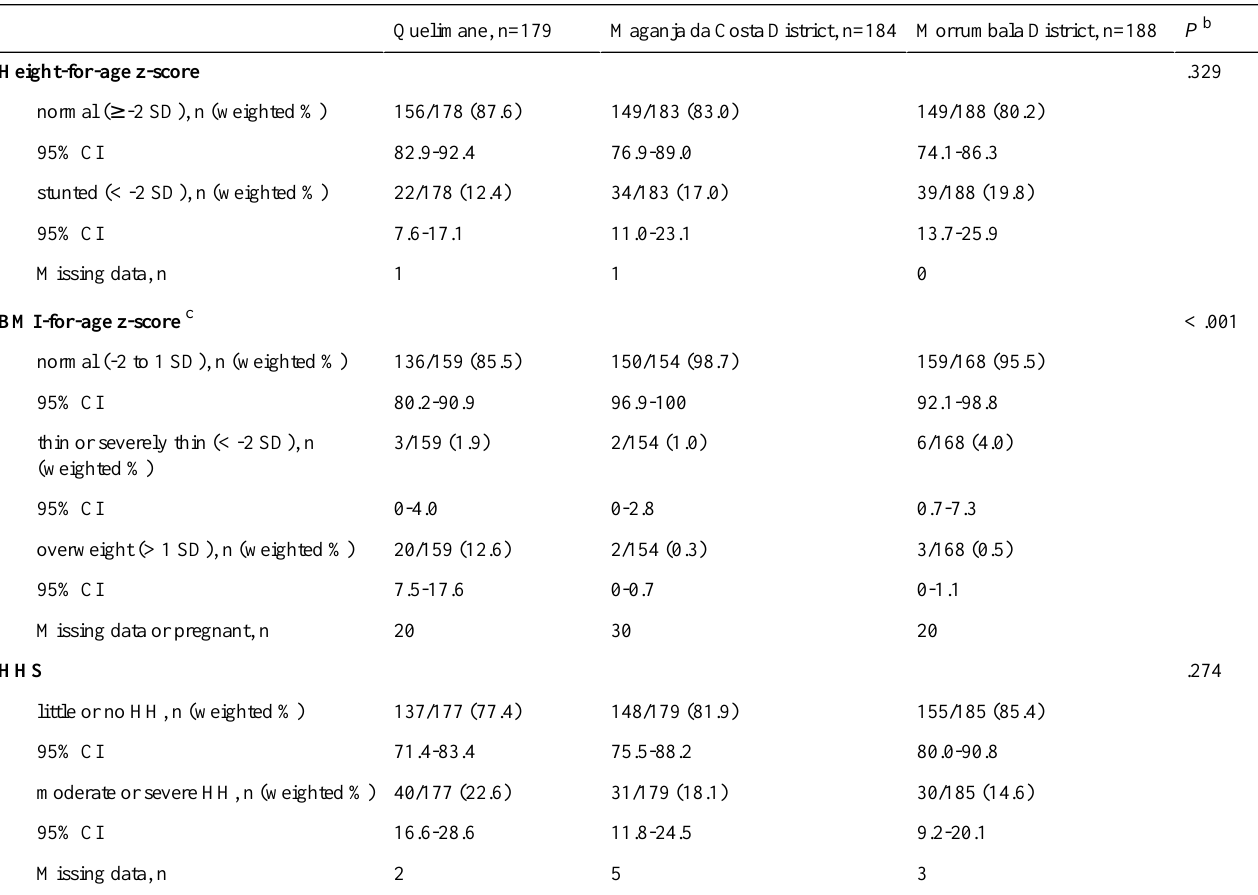
Table 2. Prevalence estimates (weighted percentages) for categories of height-for-age and BMI-for-age z-scores, and Household Hunger Scale in the study regions a